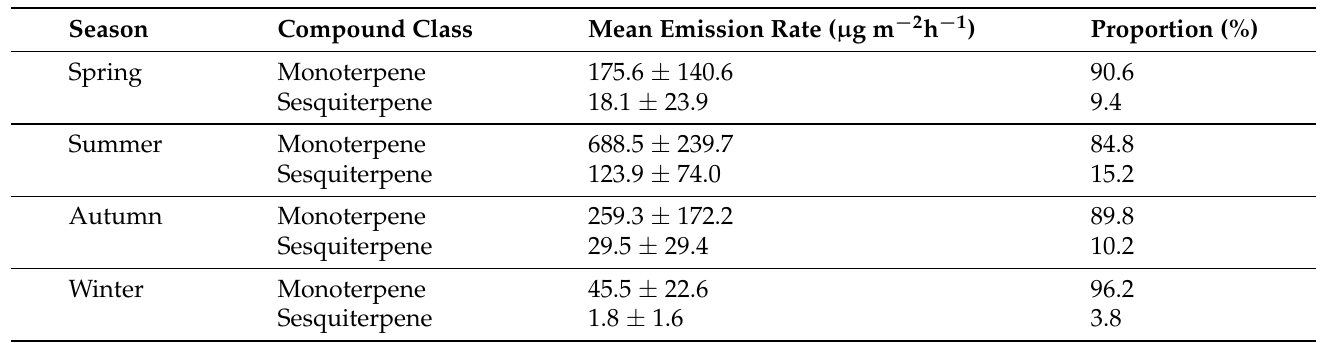
Table 5. Seasonal mean emission rate (µgm − 2 h − 1 ) of each compound class of terpenes in the Saneum-ri area.